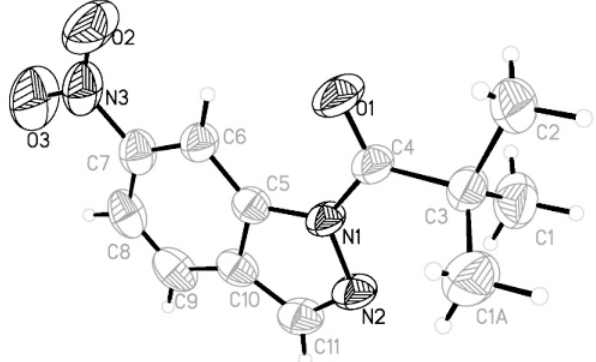
Table 2. Atomic coordinates and displacement parameters (in Å 2 )